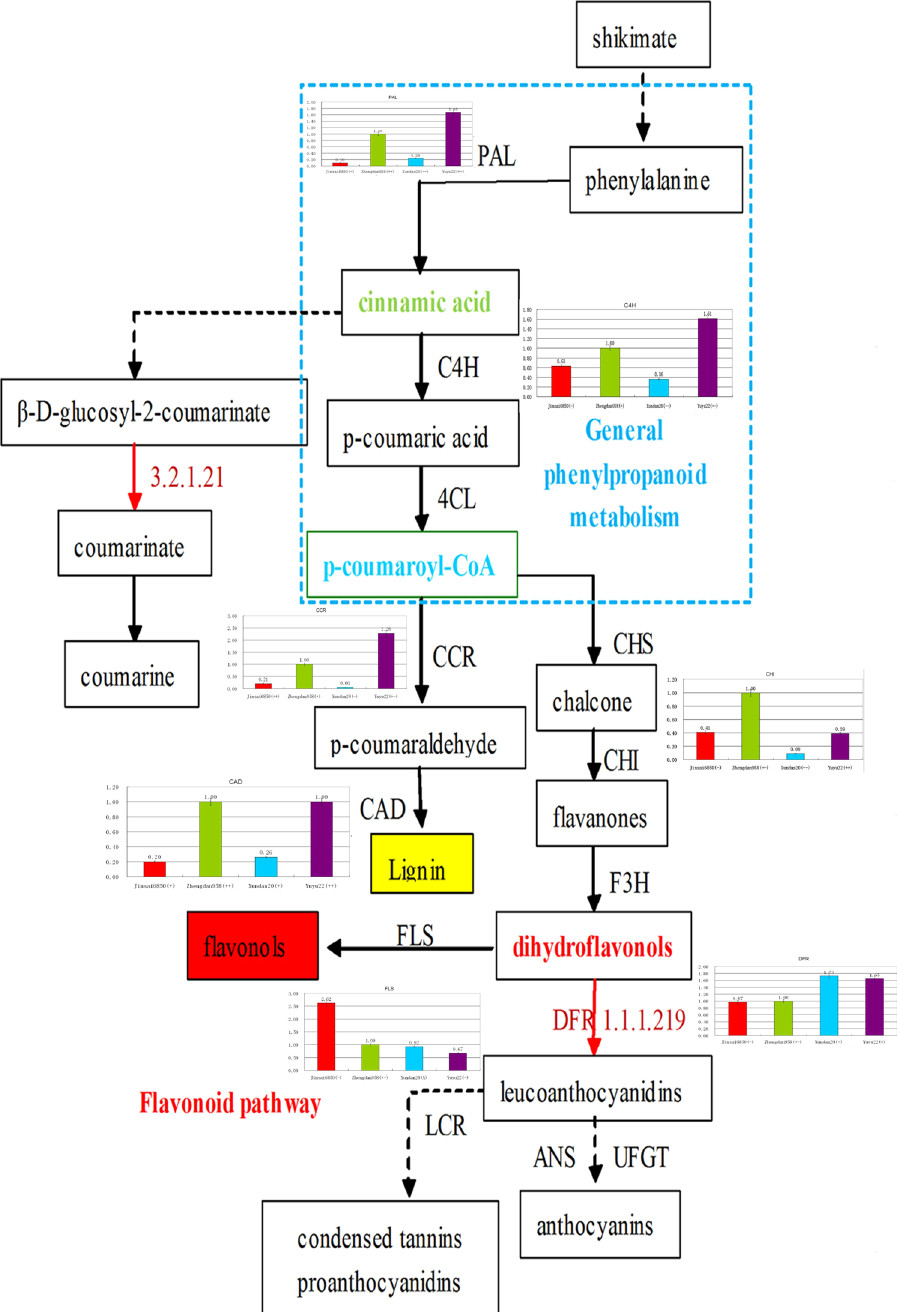
Figure 6. Summary of the phenylpropanoid metabolic pathway as well as the relative expression levels and patterns of key genes in the hybrids. Genes with the associated EC number are provided. Accessions encode the differentially accumulated proteins identified in this study. PAL, phenylalanine ammonia lyase; C4H, cinnamate 4-hydroxylase; CCR, cinnamoyl-CoA reductase; CAD, cinnamyl-alcohol dehydrogenase; FLS, flavonol synthase; DFR, dihydroflavonol 4-reductase; CHS, chalcone synthase; CHI, chalcone isomerase; and F3H, flavanone